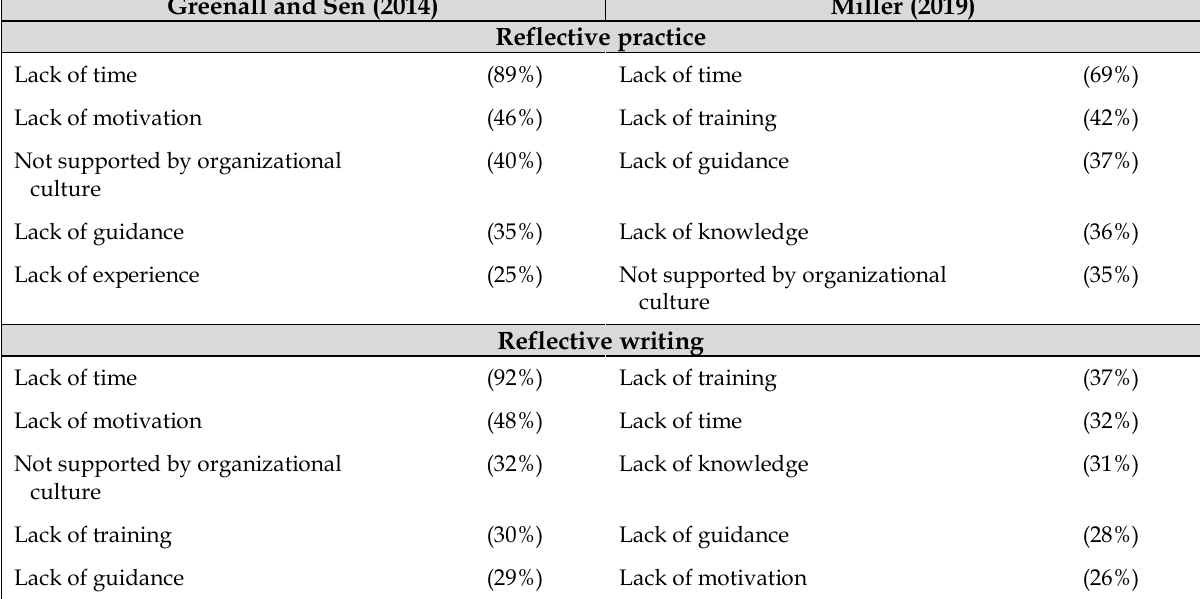
Table 4 Most commonly selected barriers to reflective practice and writing Greenall and Sen